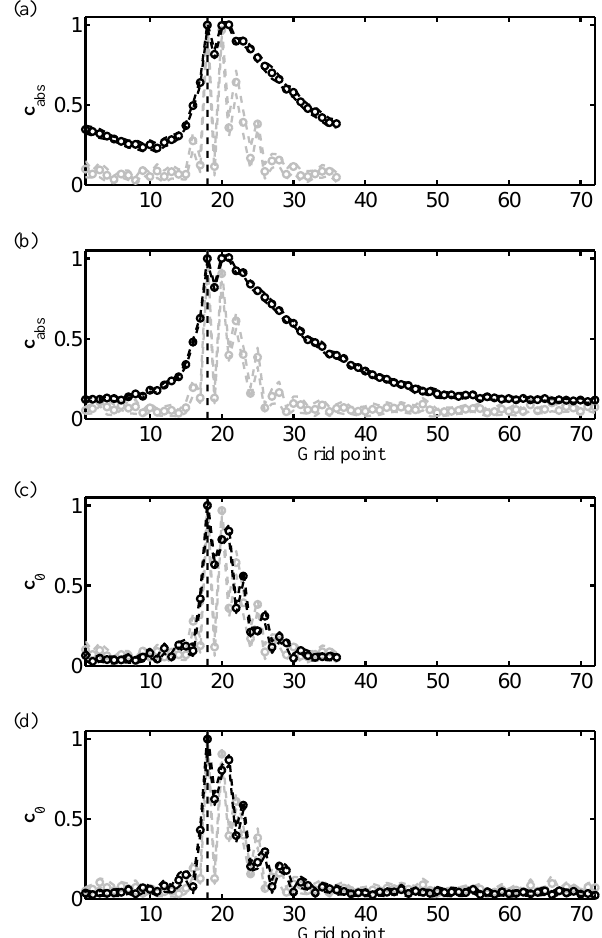
Fig. 3. Evaluation of (10), plots (a) and (b) , and (11), plots (c) and (d) , for the deterministic ( a = 0) Lorenz 95 system is indicated by the black lines. The grey lines indicate the absolute value of the response, |h δ x i| . The number of elements in the state vector for (a) and (c) is d = 36 and for (b) and (d) is d = 72. The vertical scale has been normalised so that c abs ,k = c 0 ,k = | δx k | = 1 where k = 18. The location of the forcing δf 18 is indicated by the vertical dashed line and statistical error, 2 standard deviations divided by the square root of the number of integrations, is smaller than graphical